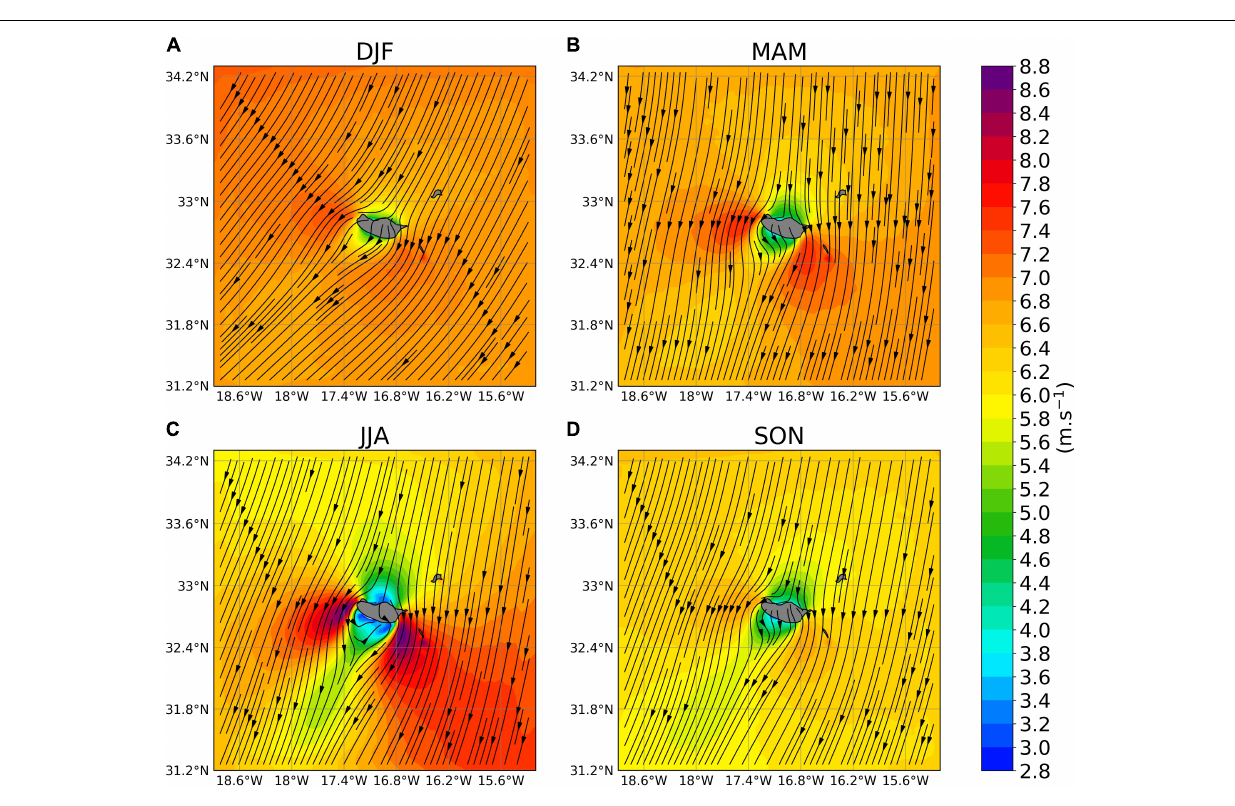
and decadal variability were found to be controlled by the regional PBL height, defined as the height of maximum stability in the low troposphere. Figure 4 shows the seasonal mean potential temperature gradient in the north upstream sampling point ( Figure 1B ), indicating a much more stable